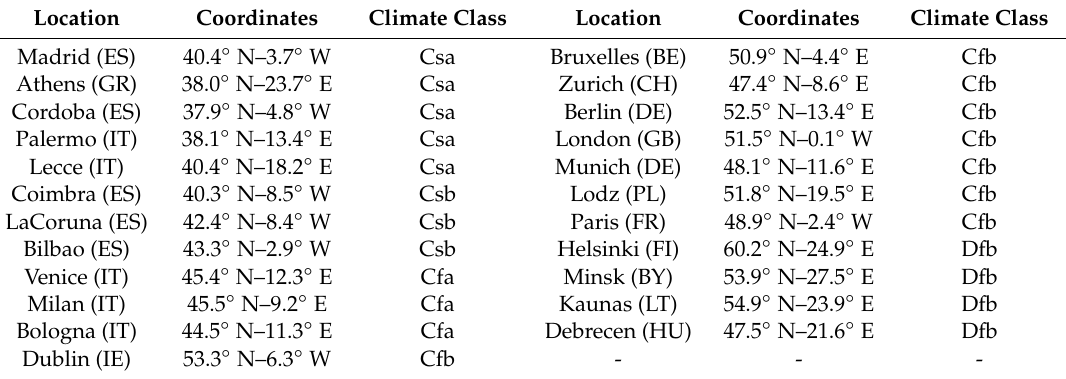
Table 1. List of the considered locations with geographical coordinates and the Köppen–Geiger Climate